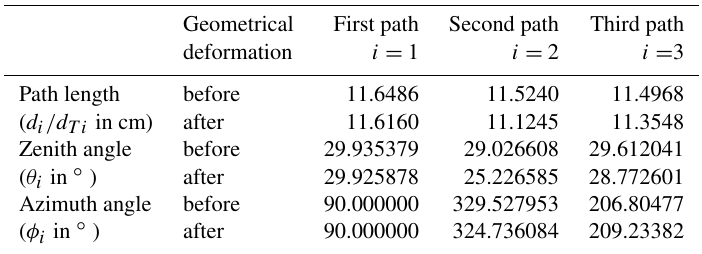
Table A1. The lengths, zenith angles, and azimuth angles of sonic paths in the IRGASON (serial no.: 1131) anemometer coordinate system before and after its geometrical deformation (measured using a coordinate measurement machine on 9 September 2014 before the deforma- tion and on 6 March 2016 after deformation). Geometrical First path Second path Third path deformation Path length